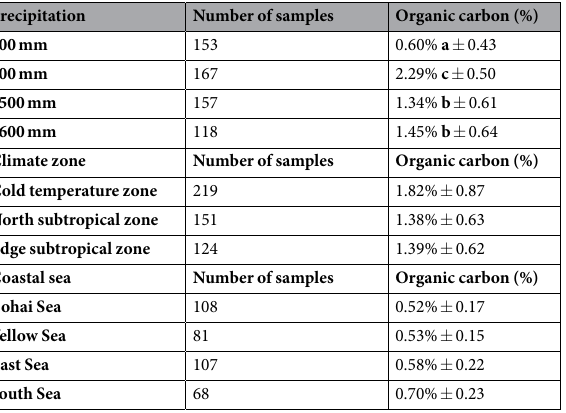
Table 2. The concentrations of organic carbon in the four precipitation regions, three climate zones, and four coastal seas. Data with a, b, and c show significant difference at α = 0.05 (Duncan